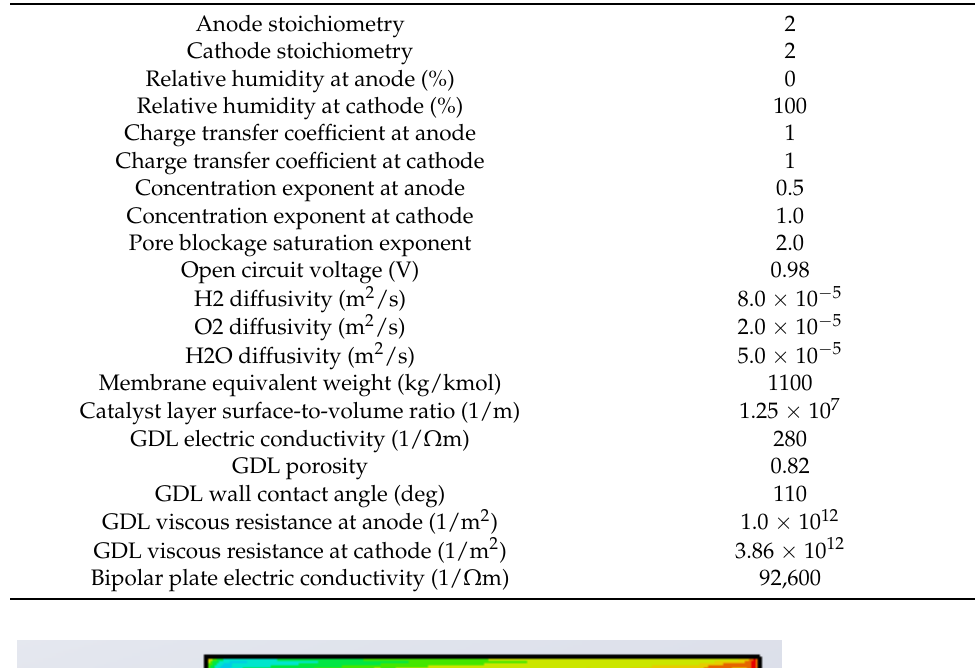
Table 5. Fuel cell CFD parameters.